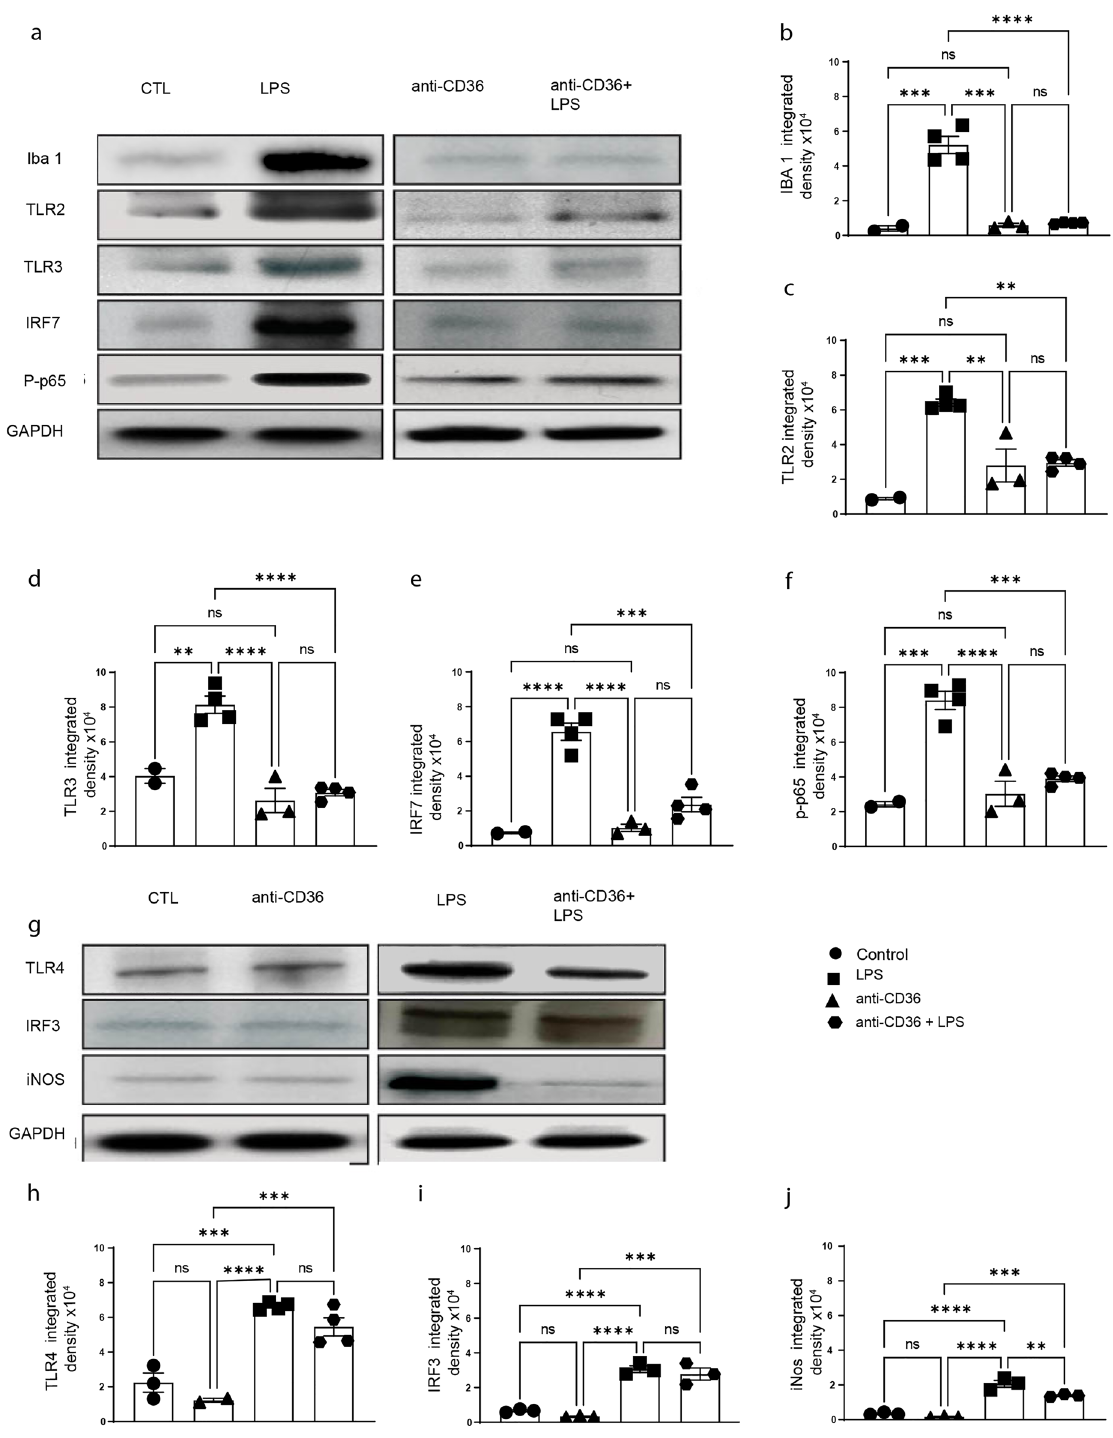
Figure 4. Blocking CD36 significantly alters TLR-2 and TLR-3 signalling. ( a ) Western blot of whole brain protein lysates from the control (saline), anti-CD36, LPS and anti-CD36 + LPS injected pups. ( b ) Iba1, ( c ) TLR2, ( d ) TLR3, ( e ) IRF7, ( f ) phosrpho-P65 expression levels were quantified in different conditions. GAPDH was used as loading control A significant increase in the levels of all the tested proteins is observed after LPS injection. Treating the pups with anti-CD36 before LPS injections considerably reduces their expression to the level as observed in the control pups. ( g ) Western blot of total protein lysates from the control, anti-CD36, LPS and anti-CD36 + LPS injected mice. ( h ) TLR4, ( i ) IRF3, ( j ) iNOS expression levels were quantified in above-described conditions. GAPDH is used as loading control. A significant increase in the levels of all the proteins tested is observed after LPS injection when compared to control and anti-CD36 treated mice. Of note, LPS-mediated increase in expression of TLR4/IRF3 is maintained in the anti-CD36 + LPS treated group. The entire data was presented as mean ± SEM and statistical significance between the groups was achieved using one-way ANOVA with Tukey’s multiple comparison test (ctl vs LPS, ctl vs anti-CD36, LPS vs anti-CD36 + LPS) and depicted as ****p ≤ 0.0001; ***p ≤ 0.001; **p ≤ 0.01 and *p ≤